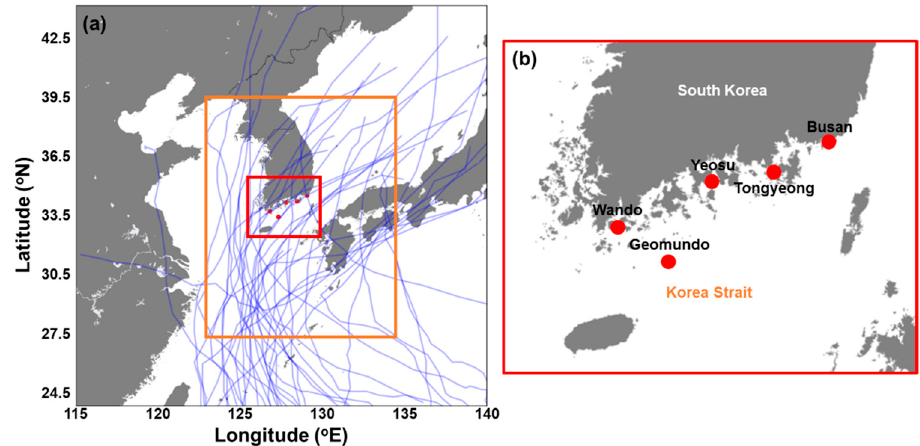
Figure 1. Study area. ( a ) Red and orange boxes indicate Korea Strait and domain area of Global Forecast System (GFS) data, respectively. Blue lines represent trajectories of typhoons (2010–2019). ( b ) Red dots represent the five tidal stations (Wando, Geomundo, Yeosu, Tongyeong, and Busan).